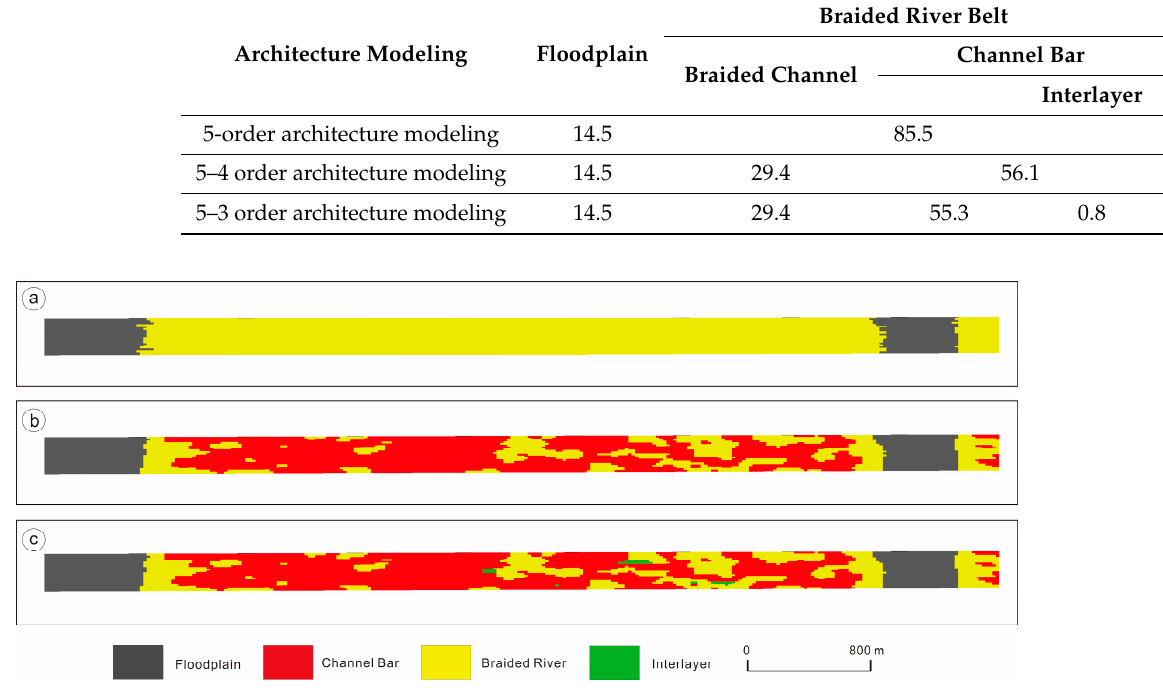
Figure 12. Results of different hierarchies of architectural model profiles (J = 423): ( a ) the first hierarchy 5-level architectural model profile results, ( b ) the second hierarchy 5–4 level architectural model profile results, ( c ) the third hierarchy 5–3 level architectural model profile results.